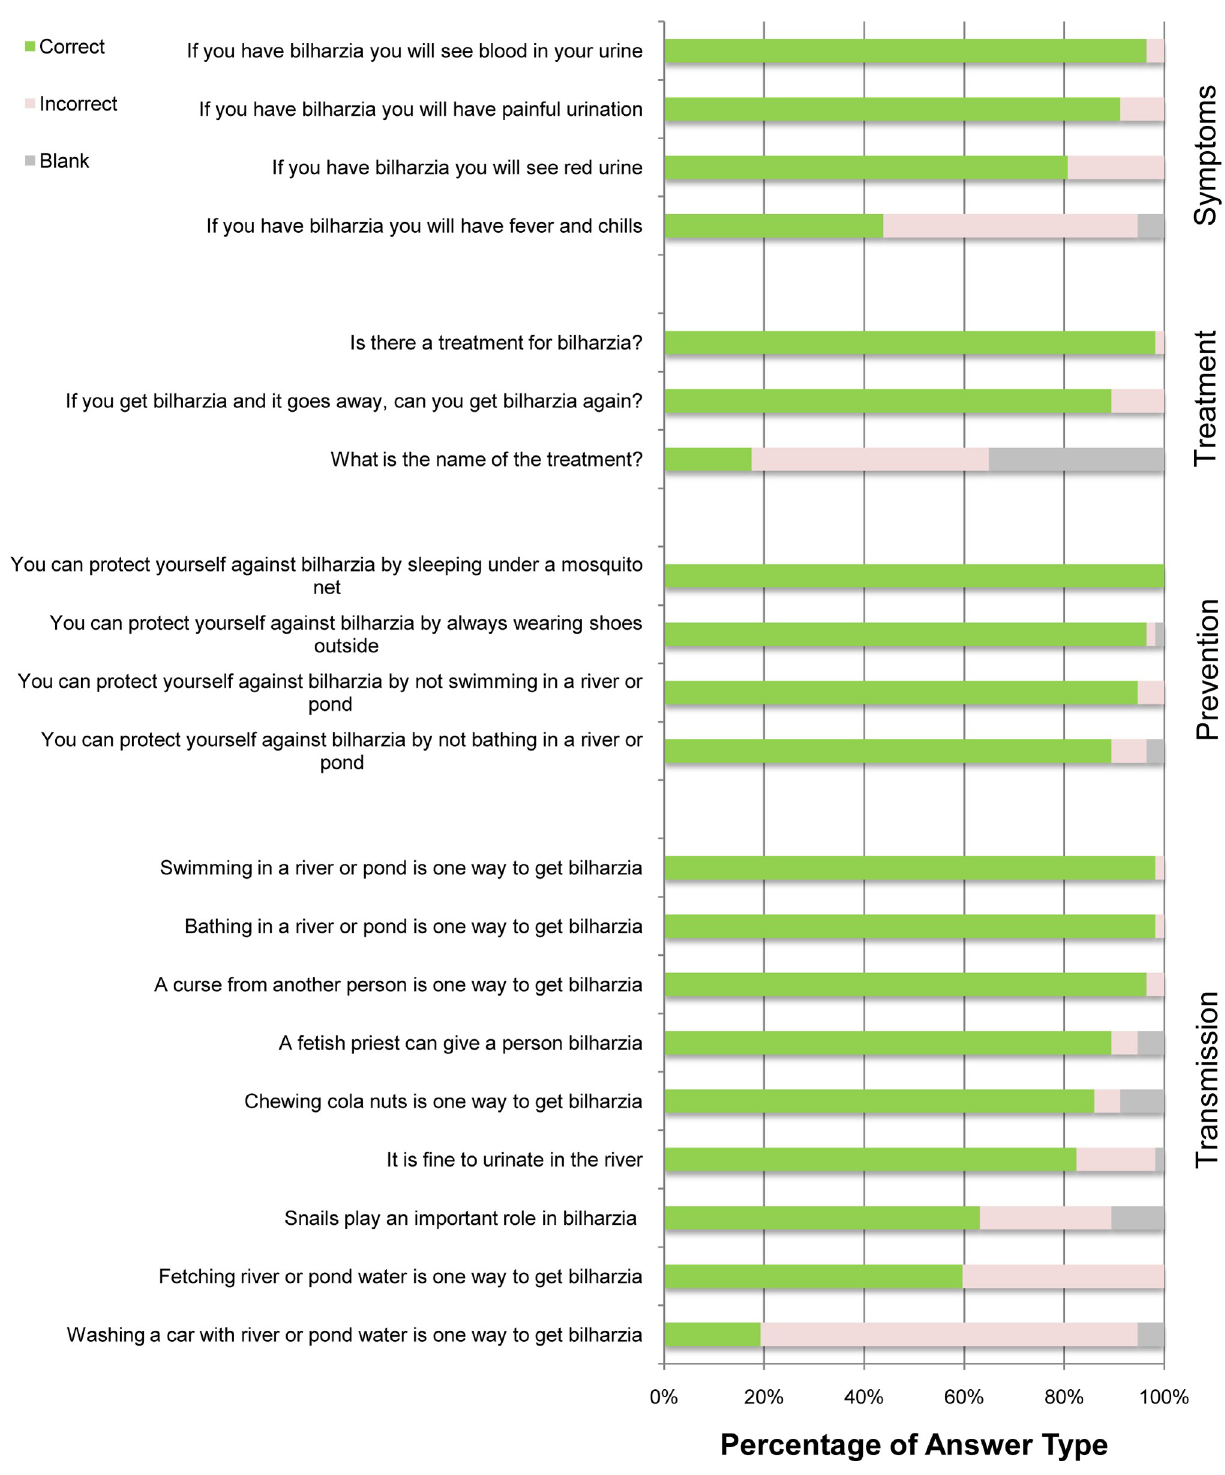
Fig 3. Responses to a 20-question UGS knowledge survey administered to teachers (n = 30 JHS2 and n = 20 P4) in the Eastern Region of Ghana; coding: 1 = transmission, 2 = treatment, 3 = protective measures, and 4 =